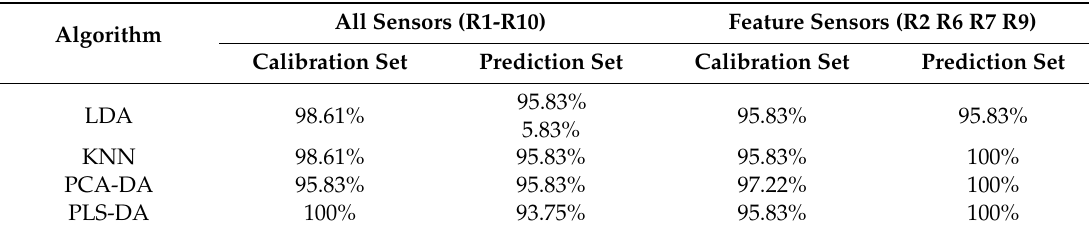
Table 2. Classification results using data from all sensors and feature